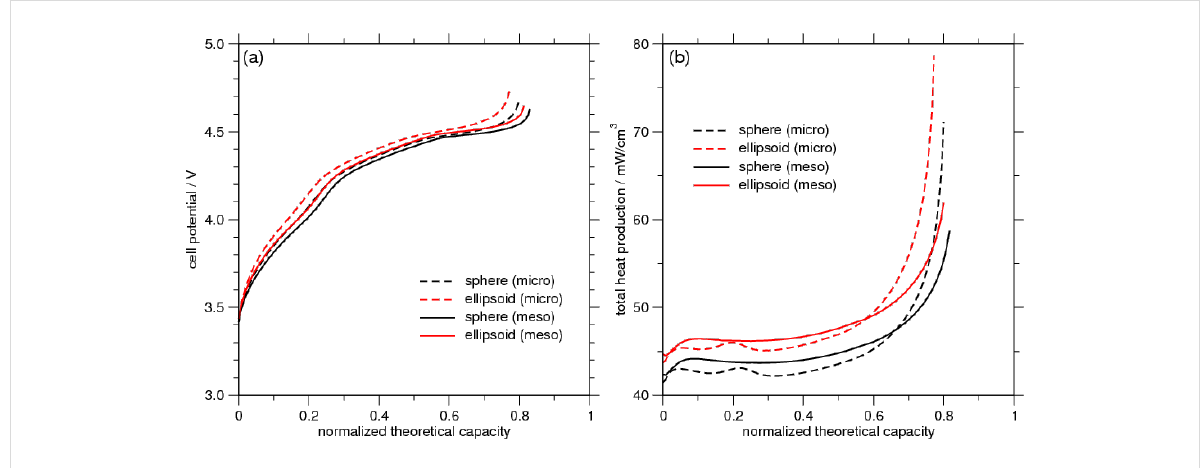
Figure 4: (a) Comparison of cell potential during charging simulations on micro- and meso-scale for the two base particles considered here, sphere and ellipsoid. (b) Comparison of heat production shown in a similar way as in (a).